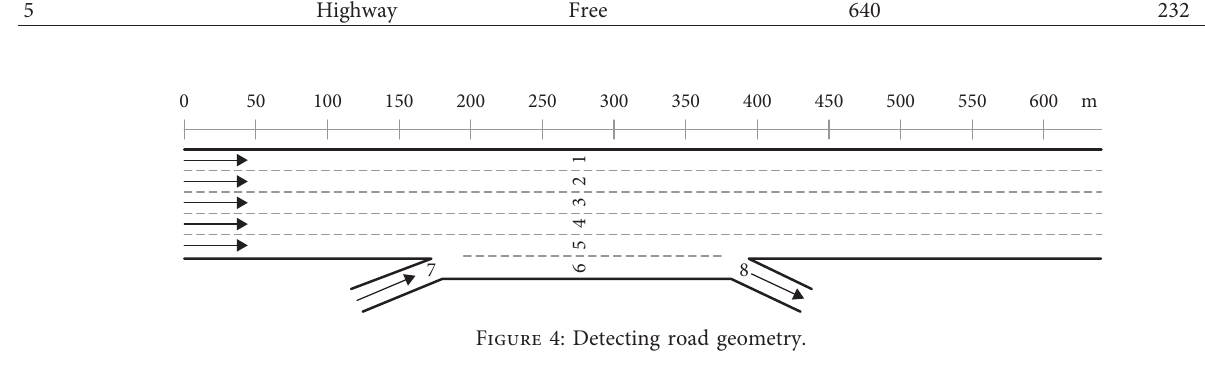
Figure 4: Detecting road geometry.